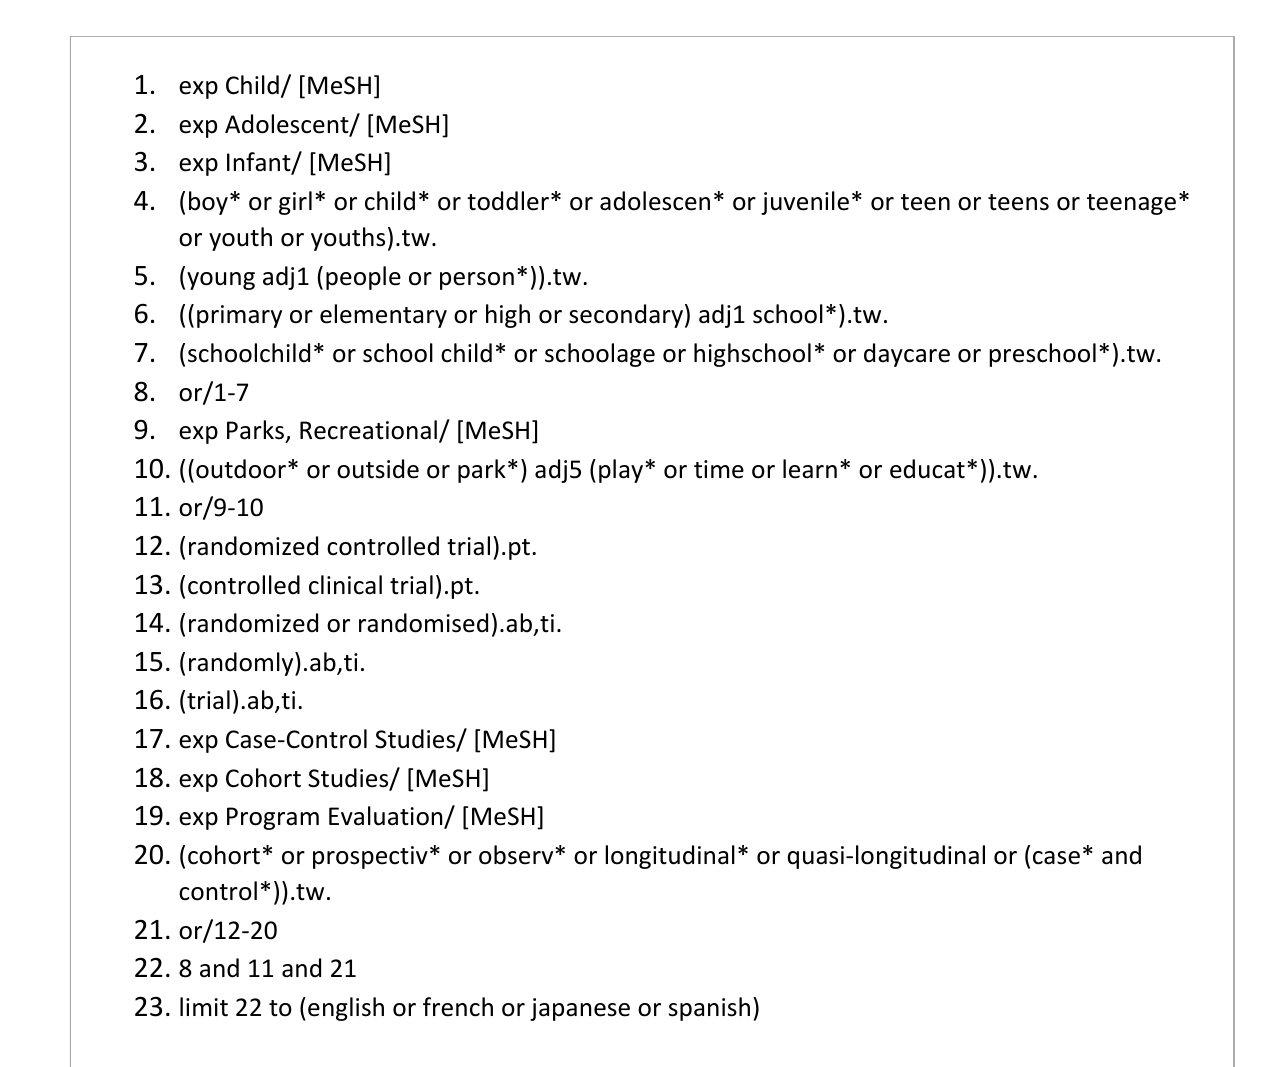
Figure 1. MEDLINE search